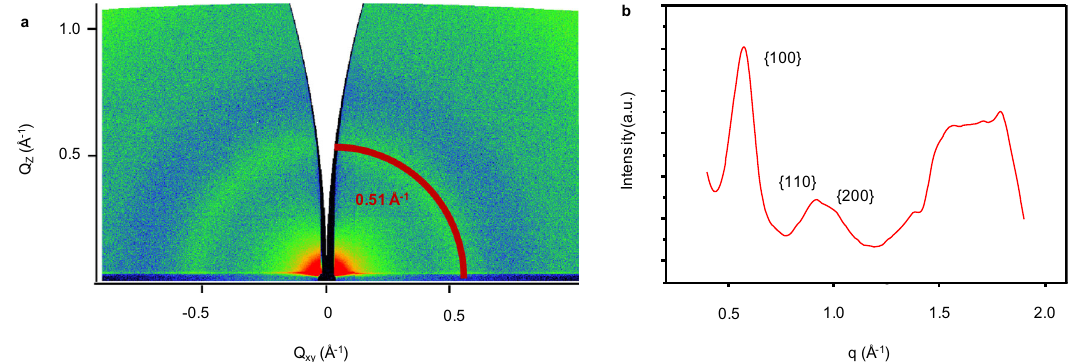
Fig. 3 GIWAXS analysis of the CTF fi lm. a GIWAXS image of CTF fi lm on 300 nm SiO 2 /Si ( q -range from 0 to ~1.0 Å − 1 ). b In-plane projection of GIWAXS data from Supplementary Fig. 9 ( q ranging from 0 to ~2.0 Å − 1 CTF fi lm thickness regulation . Controllable fi lm thickness is of great importance for molecular separation and photochemical applications 41 . In this context, we obtained CTF fi lms with thickness ranging from about 150 to 500 nm by adjusting the amount of imine precursor (from 0.017 to 0.050 mmol) and concentration of amidine (from 2.1 to 6.3 mM). The fi lm mor- phology and thickness was determined by scanning electron microscope (SEM) and AFM. SEM images (Fig. 5a, amidine: 6.3 m M ) showed no signi fi cant cracks or big particles and the